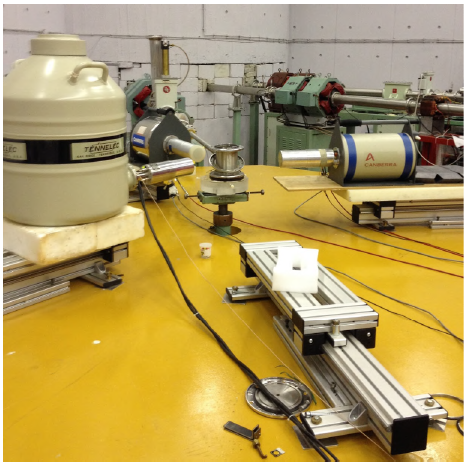
Figure 1: Picture of the detector setup used in the